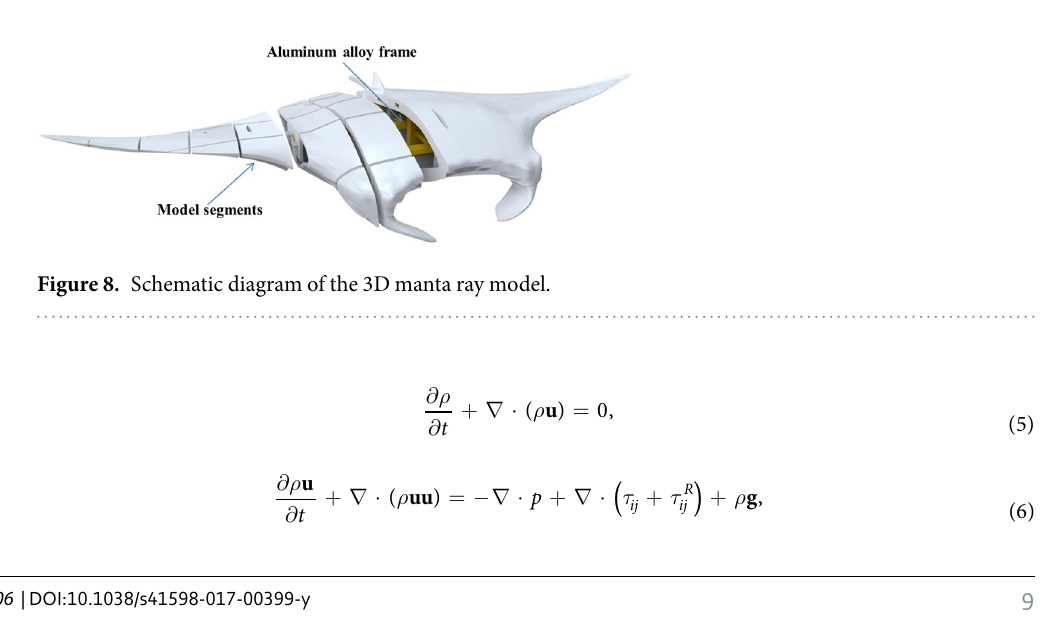
Figure 7. Cross-sectional plot for three target models. Top row: Case UW; bottom row: Case NS, where black lines correspond to the free surface, i.e. the intersection between the iso-surface (volume fraction = 0.5) and cross-sectional plane; 1st column: magnitude of the vorticity at U = 1.5 m/s; 2nd column: magnitude of the vorticity at U = 4.0 m/s; 3rd column: iso-surface of the swirling strength W = 0.01 s − 1 at U = 4.0 m/s, and the iso- surface is colored by the magnitude of the velocity. The CAD models are created in Rhinoceros 17 .